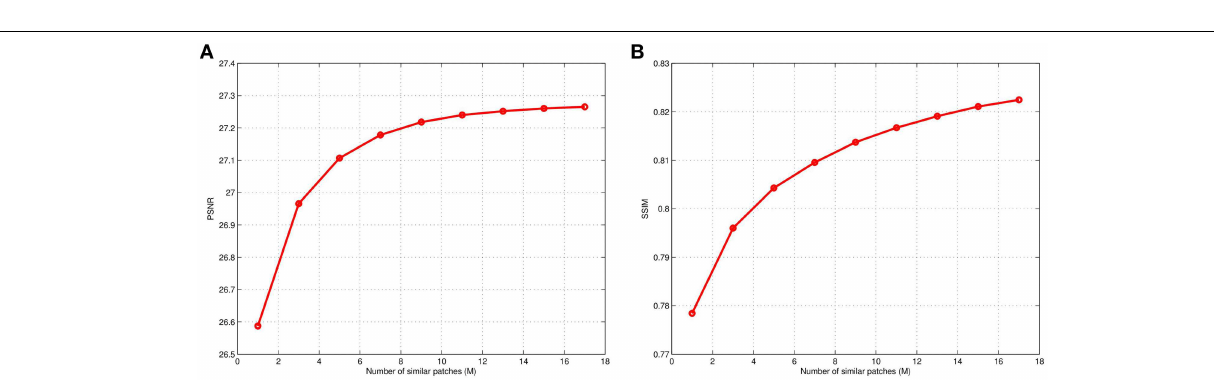
FIGURE 9 | Results showing CAWF SR performance as a function of the number of similar patches M (A) PSNR and (B) SSIM. These results are obtained with L 3 , P 9 , σ η 10 and M varying from 1 to = = =